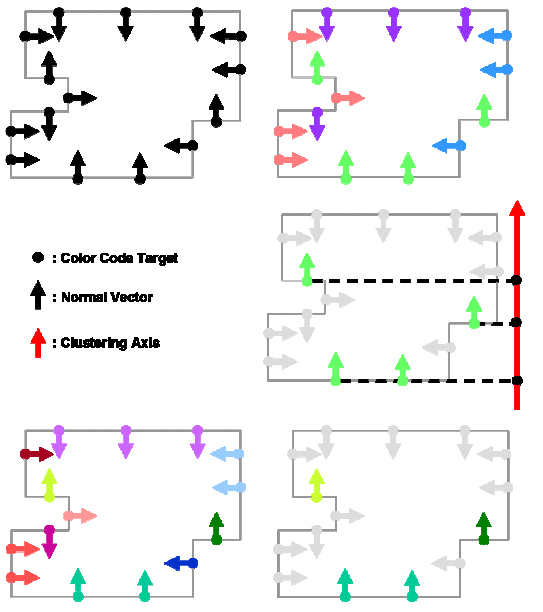
Figure 5. Clustering process. Top Left: the black dots represent the 3D points of color-coded targets, the black arrows represent their normal vectors. Top Right: rough clustering of 3D points by directions of their normal vectors. Middle: refinement of clustering; the red axis is defined as clustering axis, and 3D points (green) are clustered by the value on the axis. Bottom Right: the result of clustering refinement on a direction. Bottom Left: final result of the clustering process.